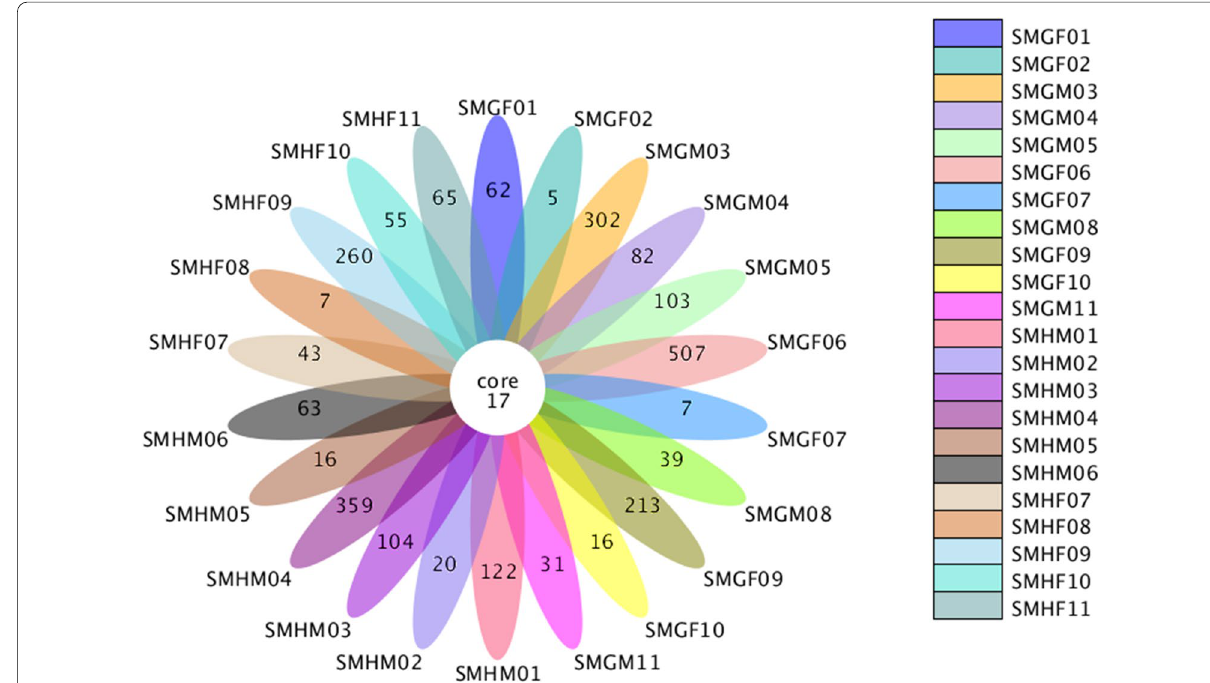
Fig. 1 The core number represents the number of OTUs shared by all